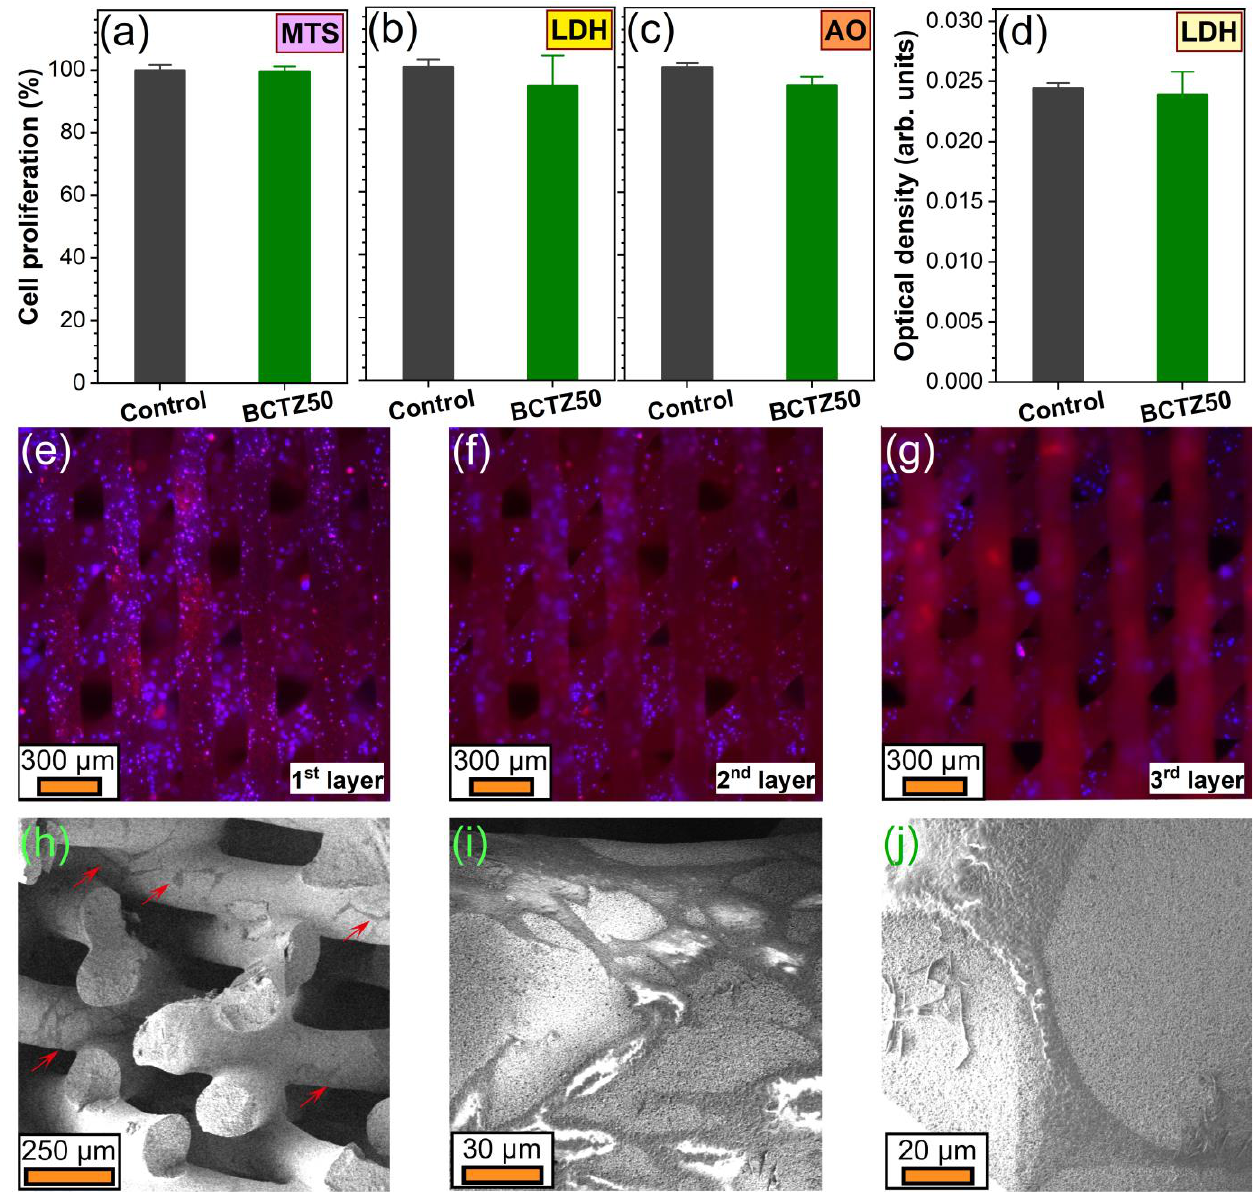
Figure 11. ( a – c ) hFOB 1.19 cell proliferation values recorded for the BCTZ50 scaffolds, determined by ( a ) MTS, ( b ) LDH and ( c ) Acridine orange (AO) tests after 14 days of culturing. ( d ) Cytotoxicity of the BCTZ50 scaffolds evaluated by an LDH test after 14 days of cell culturing. ( e – j ) Effective colonization (after 14 days) of the BCTZ50 scaffolds with hFOB 1.19 cells evidenced by ( e – g ) epi-fluorescence microscopy images focused on the first three printed layers and by ( h ) FE-SEM analysis. ( e – g ) The actin cytoskeleton is stained with red (Alexa Fluor ™ 546 phalloidin, Thermo Fisher Scientific, Waltham, MA, USA), whilst the cell nuclei are counterstained with blue (DAPI). ( h ) Several cell bundles are indicated on the FE-SEM image with red arrows. ( i , j ) Morphology of hFOB 1.19 cells grown for 14 days on the surface of the filaments constituting the BCTZ50 macro-porous scaffolds, revealed by FE-SEM investigations.